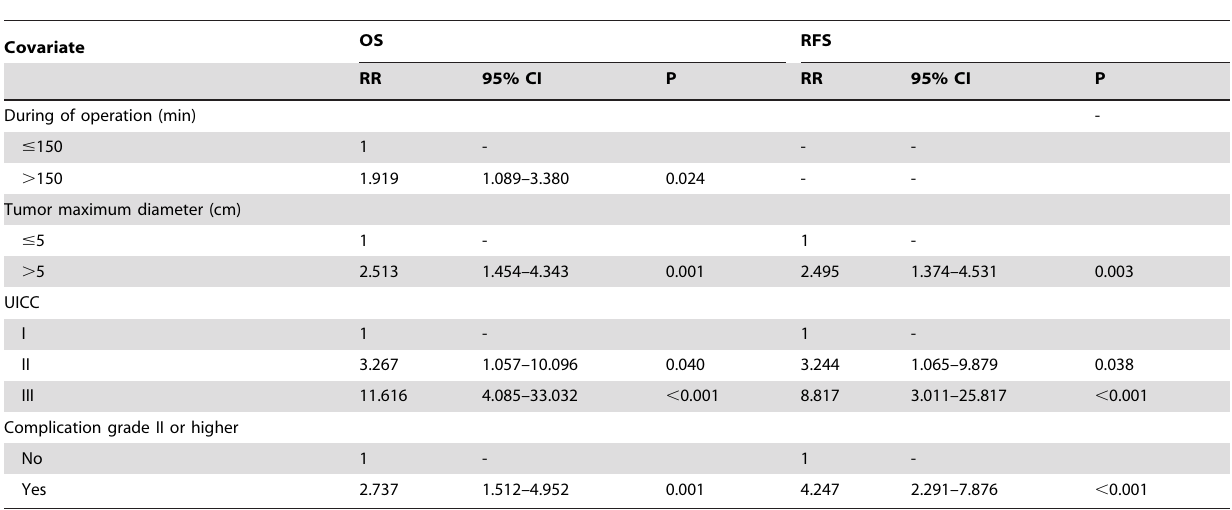
Table 3. Multivariate analysis of prognosis factors for OS and RFS.